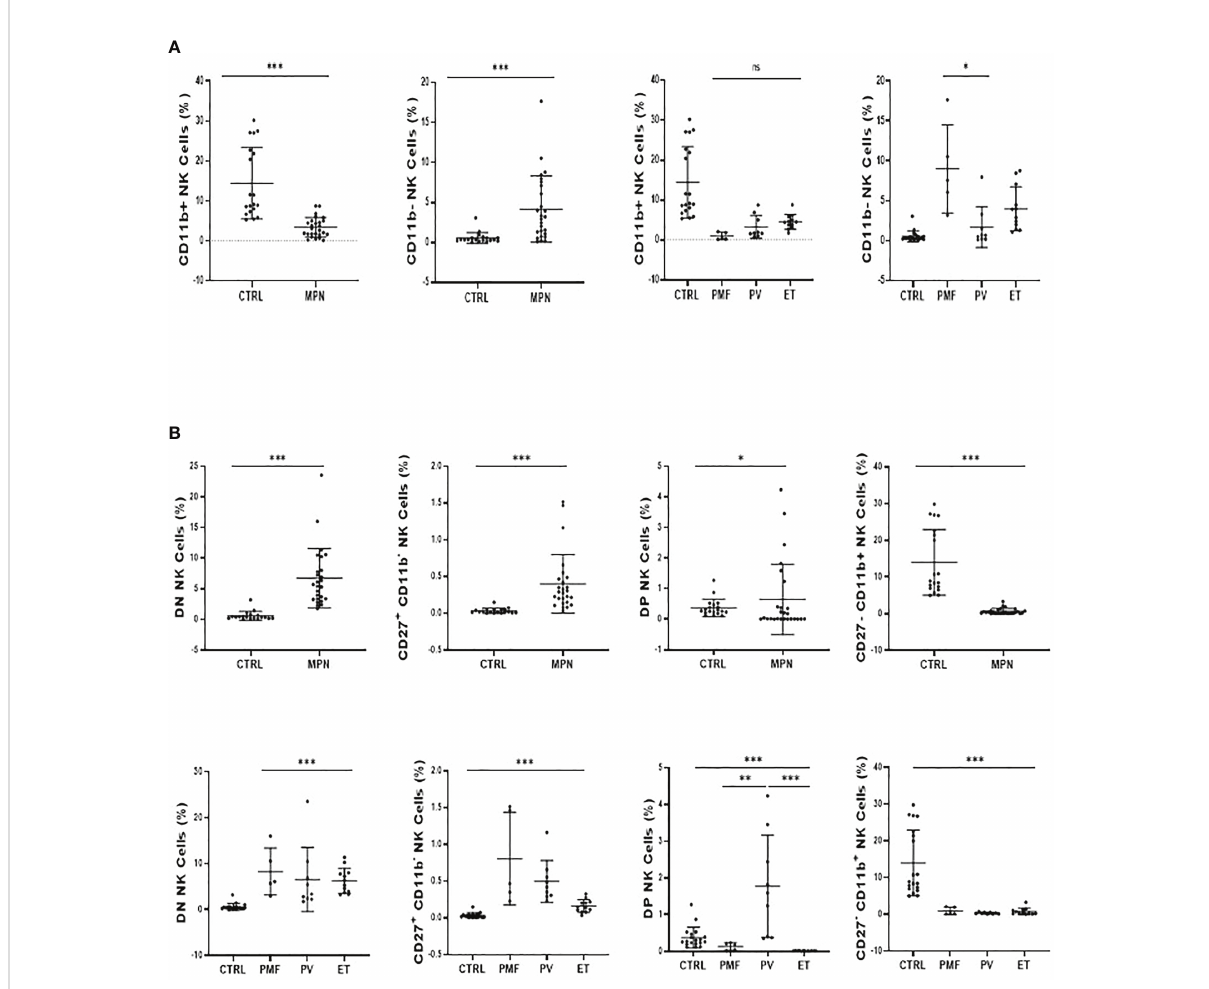
FIGURE 5 MPN patients show an imbalance between CD11b + and CD27+ NK-cell subsets. (A) The frequency of CD11b + (Mature) and CD11b − (Immature) NK cells subsets and; (B) the frequency and absolute number of CD27 − CD11b − [double negative (DN)], CD27 + CD11b − , CD27 + CD11b + [double positive (DP)], and CD27 − CD11b + . NK-cell frequency and maturation pro fi le in myeloproliferative neoplasms according to disease subtype and JAK2V617F mutation (WT or VF). CTRL, control; MPN, myeloproliferative neoplasms (n=26); PV, polycythemia vera (n = 9); ET, essential thrombocythemia (n = 12); PMF, primary myelo fi brosis (n = 5). Error bars indicate the mean (± SEM). NS, not signi fi cant (p > 0.05); *p < 0.05; **p < 0.01; ***p < 0.001; Mann – Whitney and Kruskal – Wallis